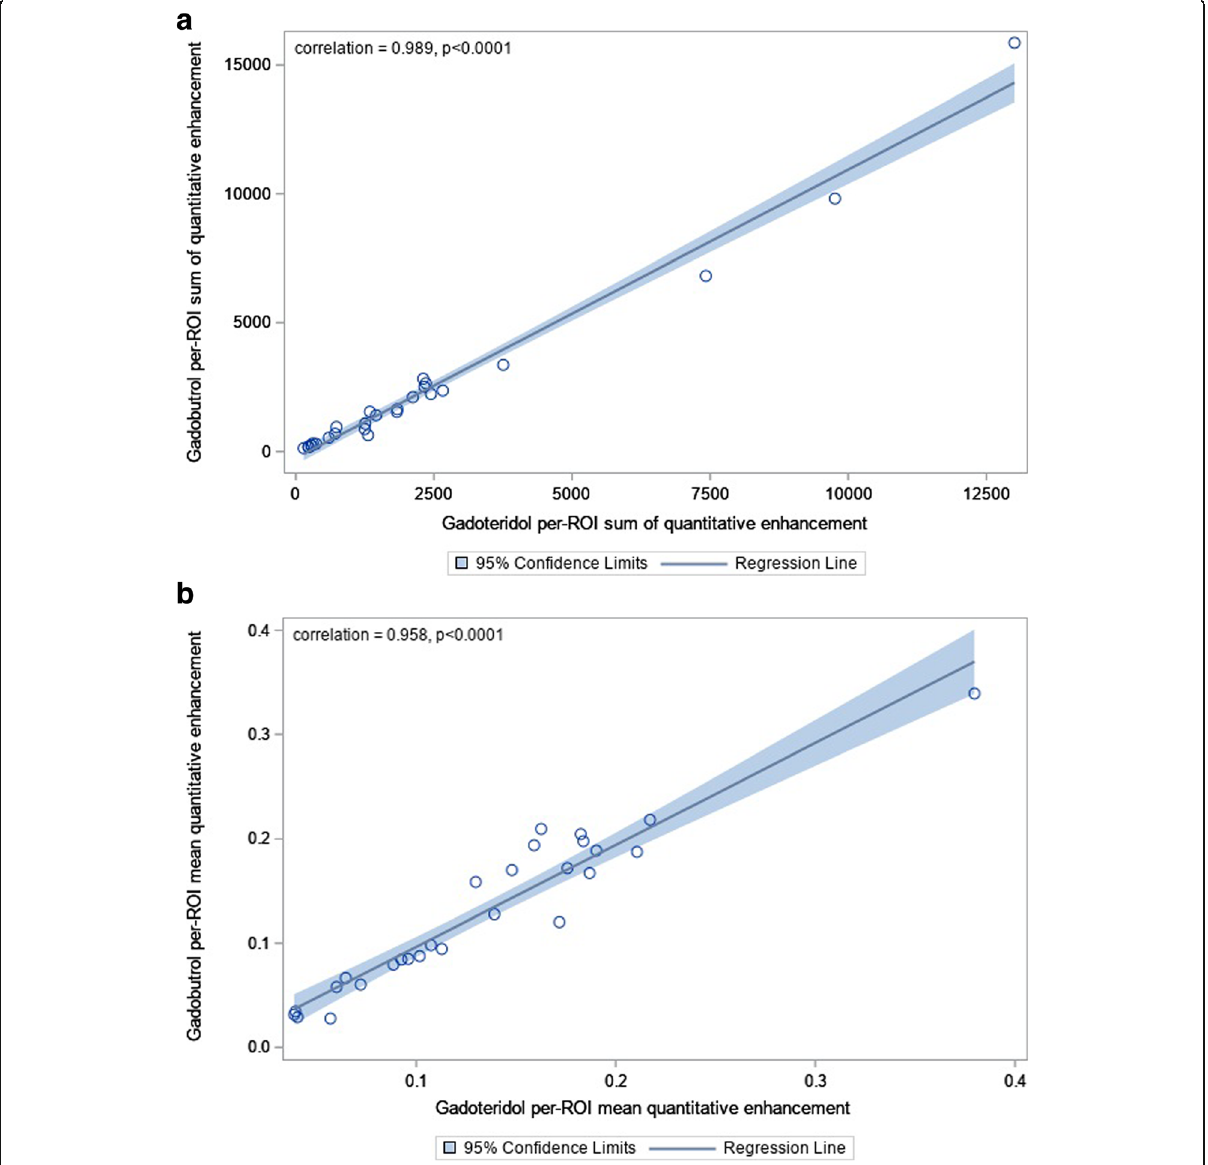
Fig. 7 Per-region of interest sum of quantitative enhancement ( a ) and per-region of interest sum of mean quantitative enhancement ( b ) for gadoteridol versus